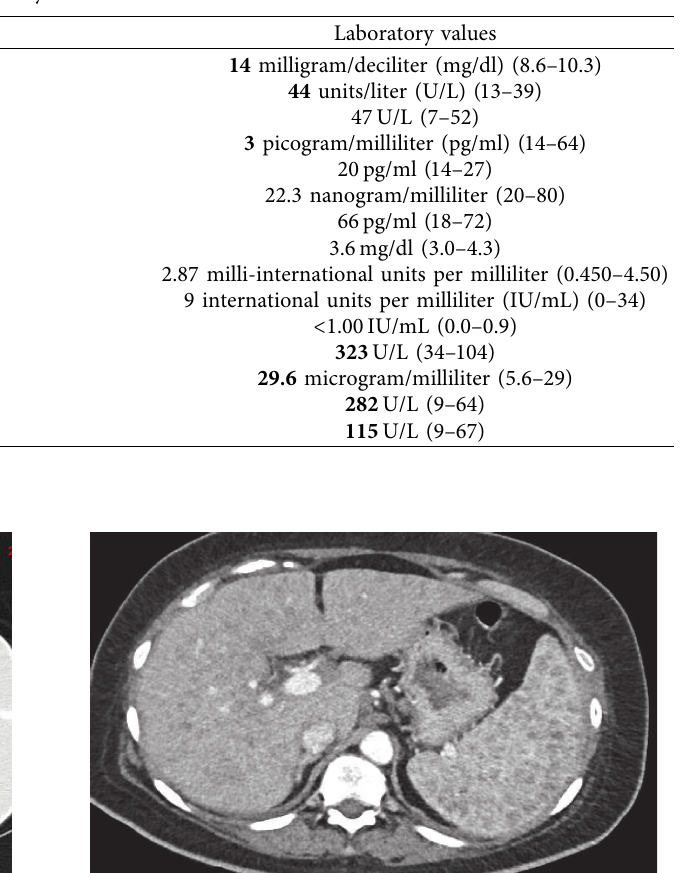
Figure 1: Neck soft tissue computed tomography revealing the left thyroid nodule. Table 1: Laboratory values on admission.